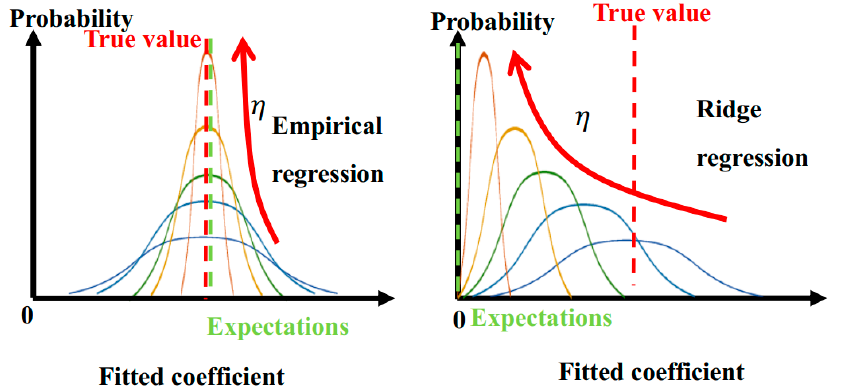
Figure 9. Analysis of empirical regression principle. The distribution of the fitted coefficient with